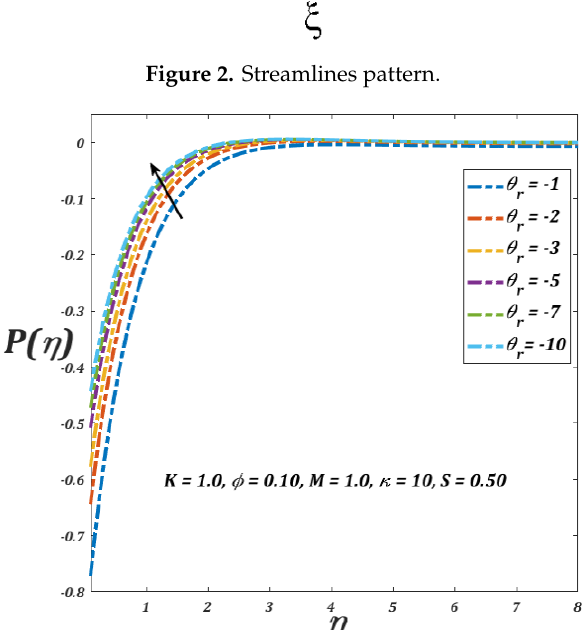
Figure 3. Pressure variation with Variable viscosity parameter.